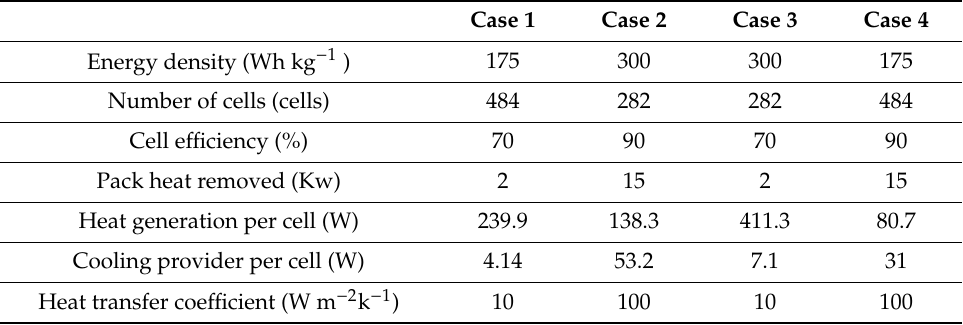
Table 2. Case conditions under a constant 350 kW charge [14]. Reproduced by permission of